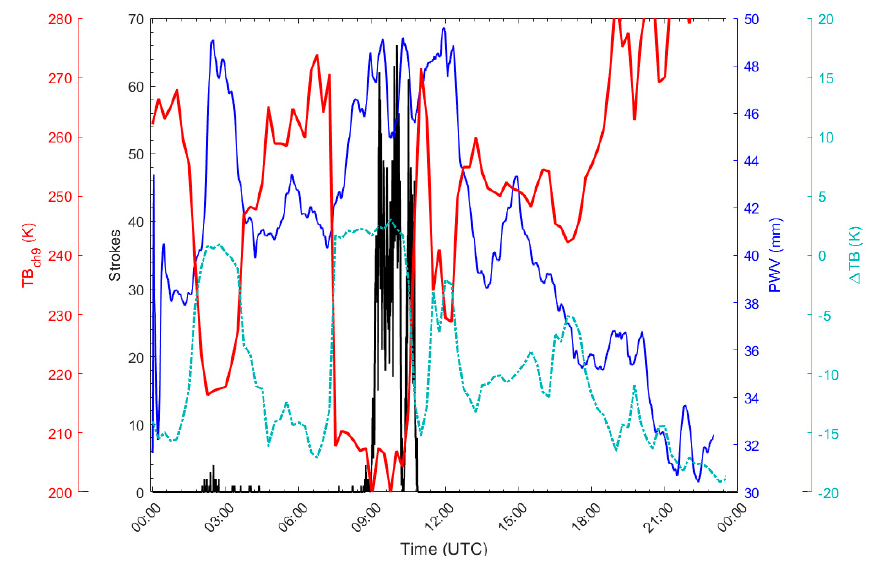
Figure 4. Trend of total number of strokes (black line), precipitable water vapor (PWV) (blue line), TB ch9 (red line), and ∆ TB (dashed sky blue line) for the whole day of 5th September 2015 over the Naples area.